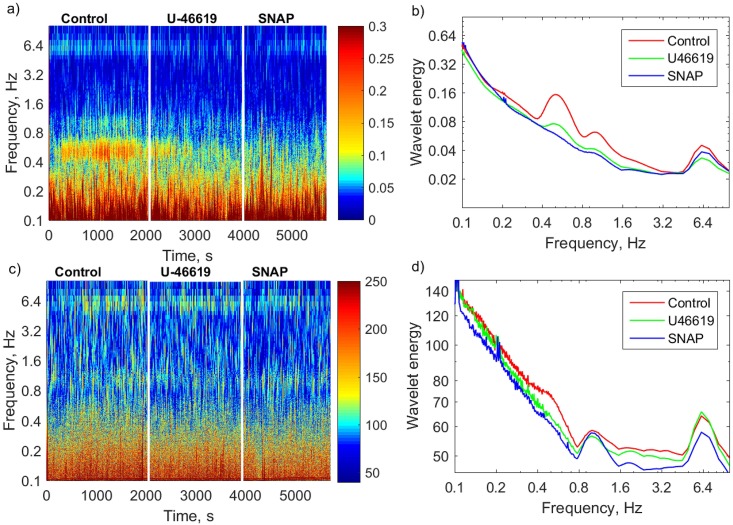
Wavelet analysis of arterial pressure and SV recordings.Analysis of (a,b) arterial blood pressure and (c,d) SV of a single retinal vessel of a representative rat. Left panels: Color-coded wavelet energy over frequencies and time. Three time intervals are selected according to the experimental protocol: control, U-46619, and SNAP. Right panels: Wavelet energy spectra. Different colors code different time intervals as the legend describes. The peak at 0.5 Hz corresponds to Mayer waves, 1 Hz corresponds to ventilation frequency and 6.4 Hz corresponds to the pulse. SV analysis reveals the same frequencies although shape of the peaks and response to drug infusion are different.